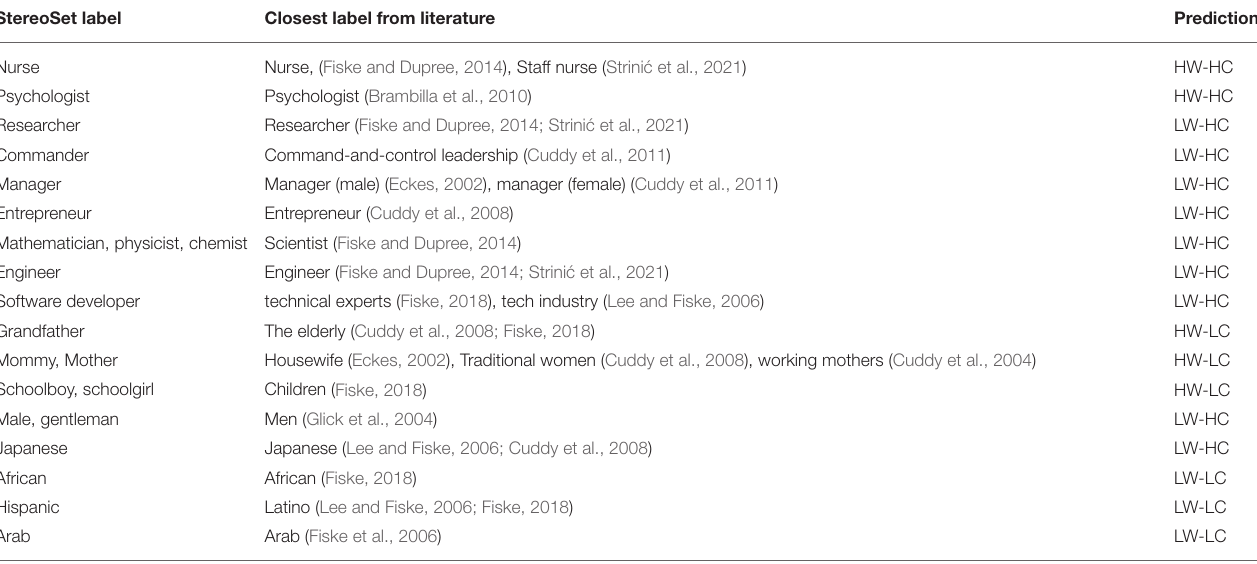
TABLE 4 | Social groups in StereoSet, along with available research findings from the social sciences literature on stereotyping. StereoSet label Closest label from literature Prediction